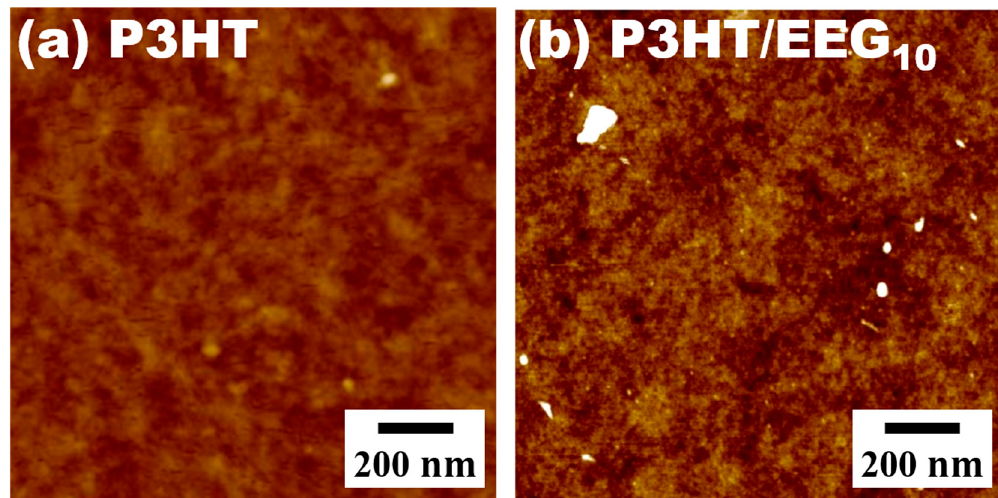
Figure 5. AFM topographies of transferred P3HT and P3HT / EEG 10 nanocomposite films via solution floating method.